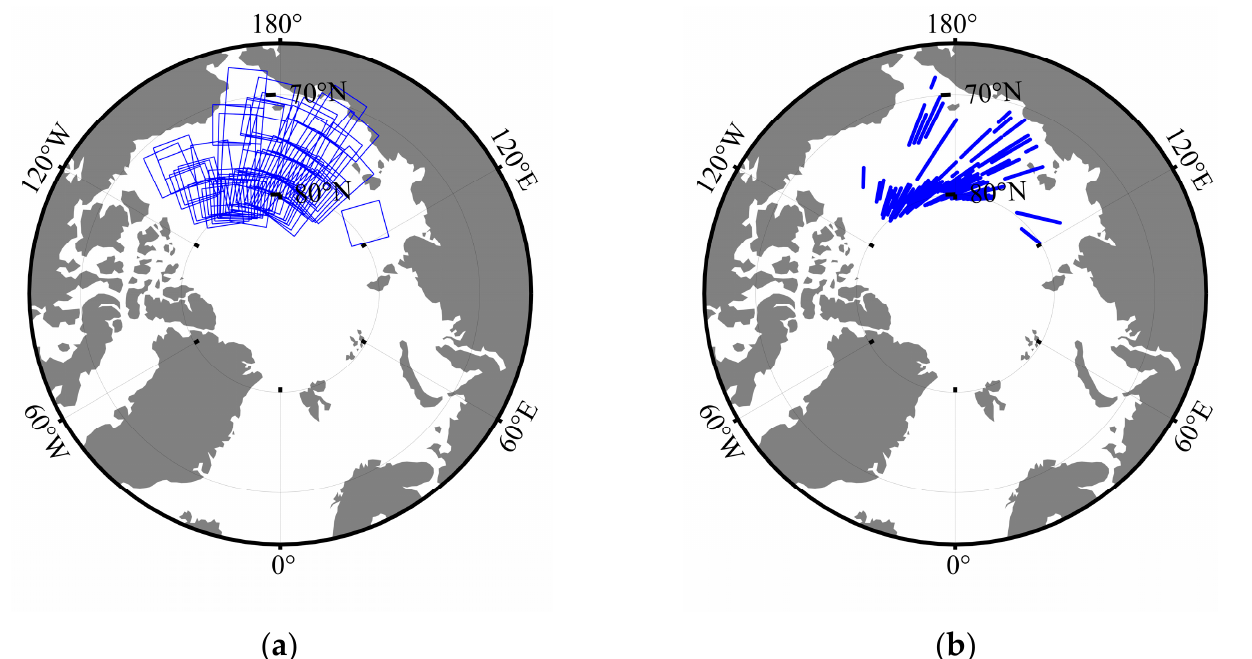
Figure 3. Areas to be studied in this paper: ( a ) Sentinel-1 SAR image edge tracks; ( b ) HY-2B radar altimeter tracks. Date: October 2019.